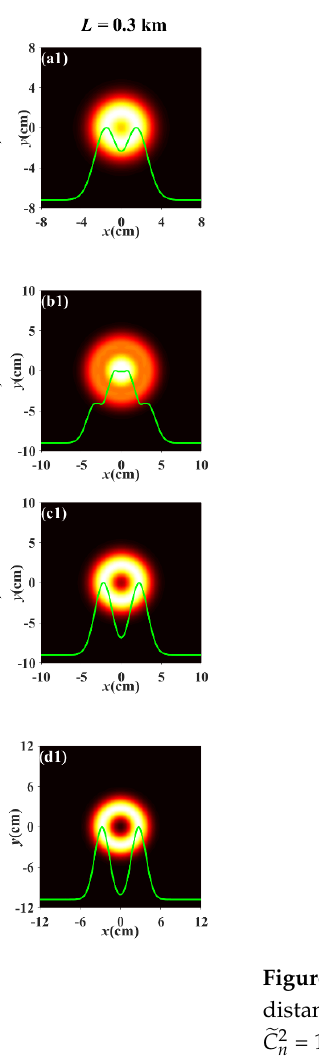
Figure 2. Normalized spectral intensity distribution of the PCTLGP beam at several propagation distances in anisotropic turbulence for different mode orders and topological charges ( ξ x = ξ y = 3, C ̃ 2 n = 1 × 10 − 17 m 3 − α , η = − 5 × 10 − 4 m − 1 ).